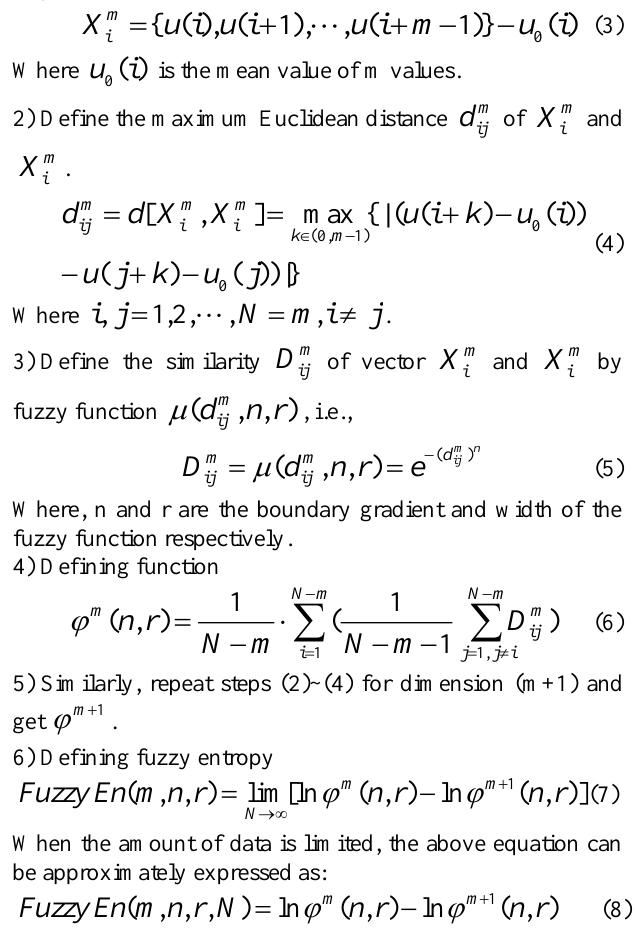
Figure 1. Coarse-granulating process of moving